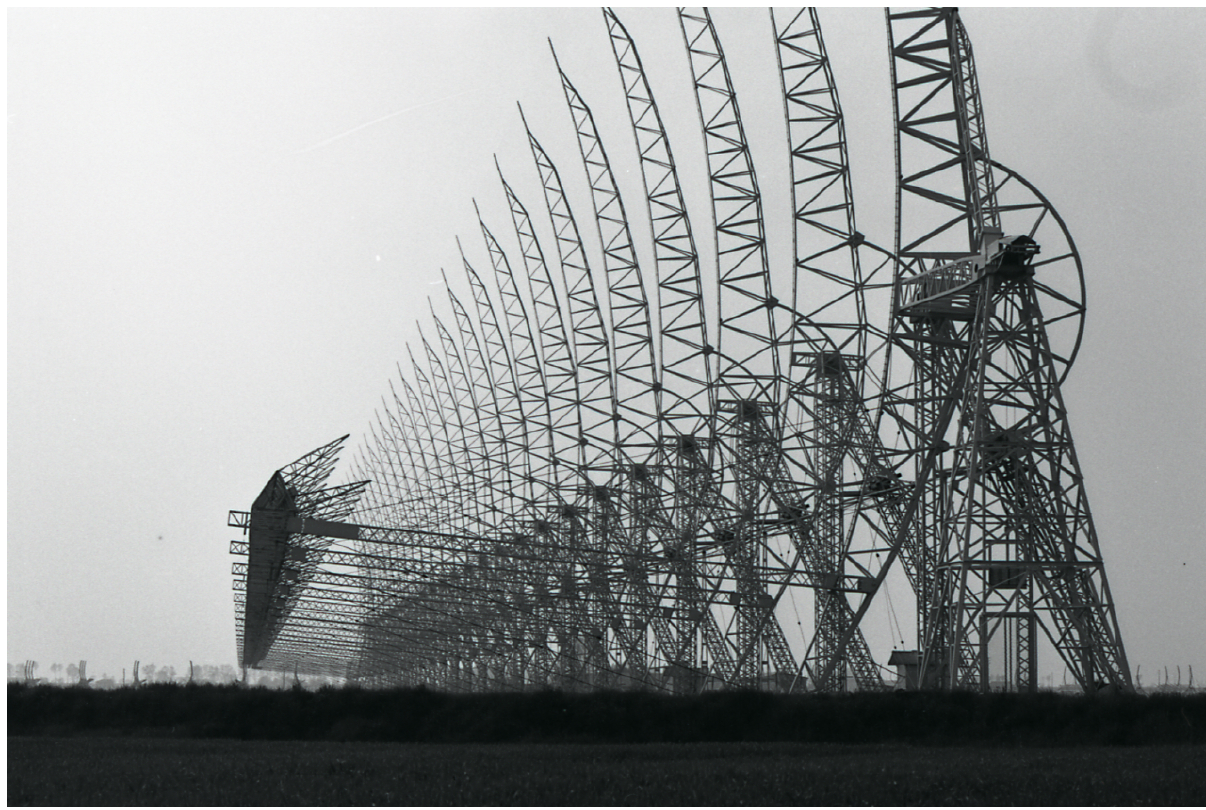
The Medicina Radio telescope (Ph. Paolo